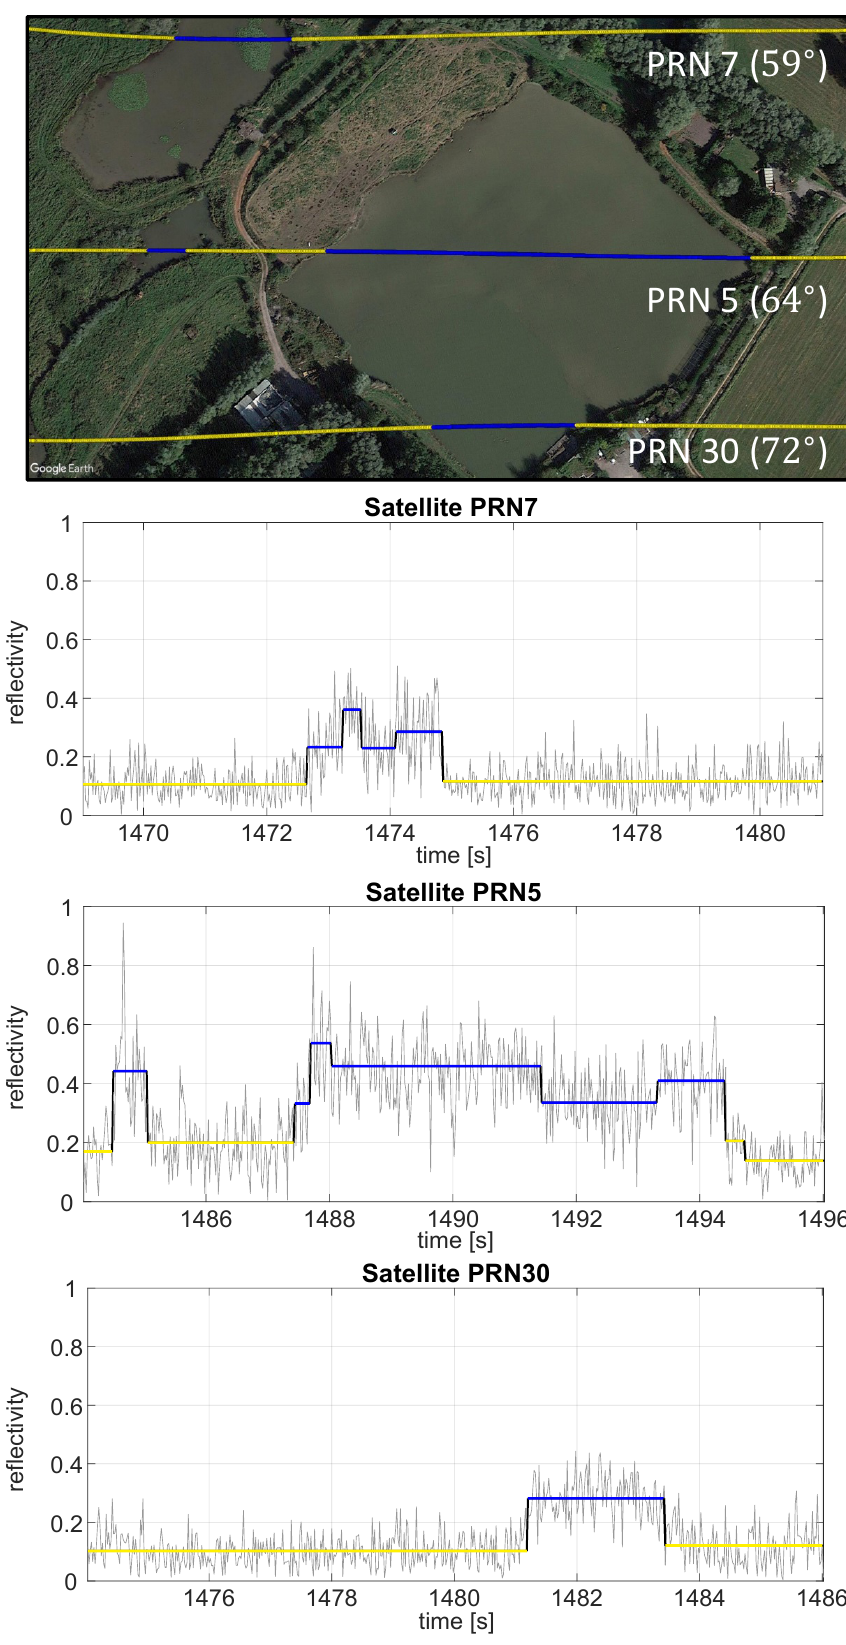
Figure 13. Automatic segmentation of the GNSS measurements by the proposed radar technique for an area located at (50.888515 ◦ N, 1.871803 ◦ E) along the